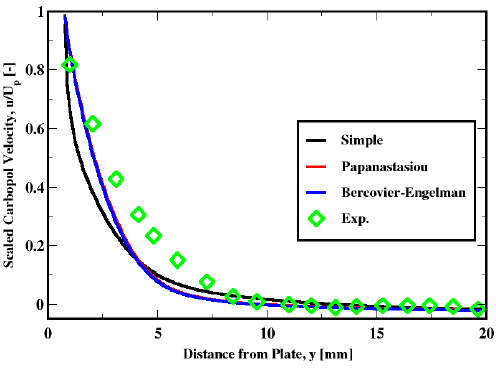
Figure 9. Sensitivity of the velocity distribution to the regularization model.